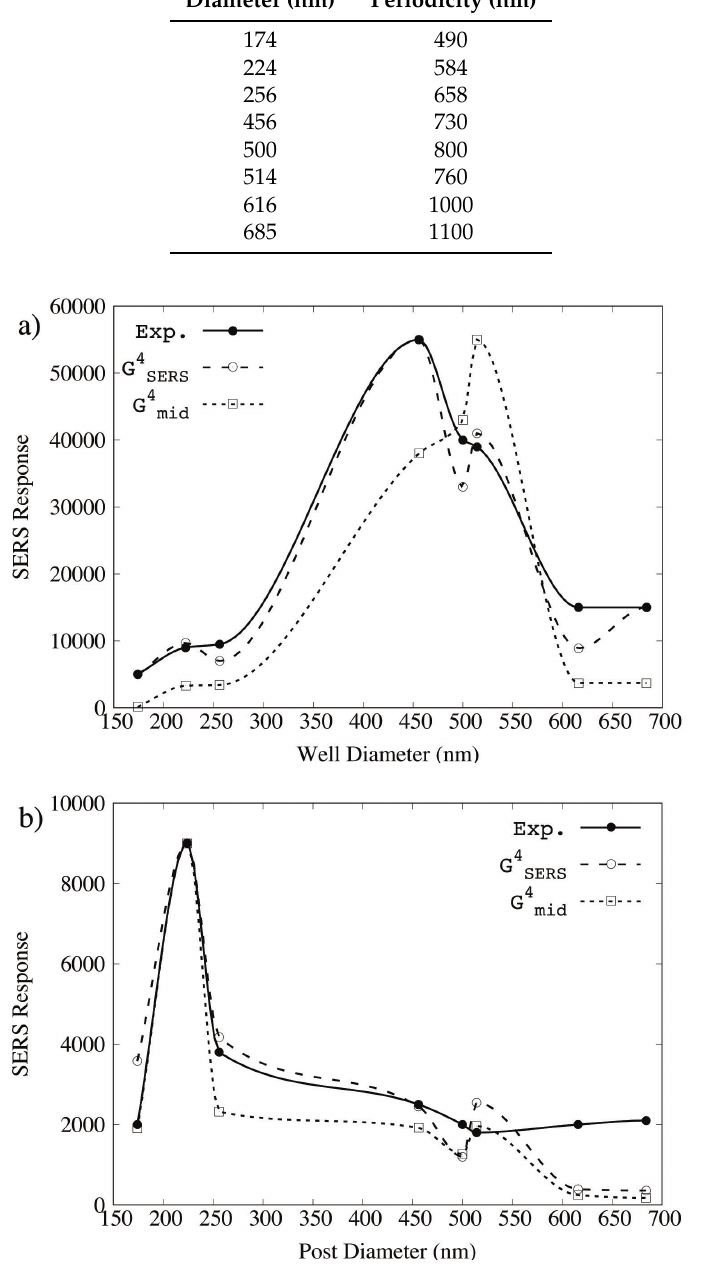
Figure 2. Comparison of experimental SERS response (exp) and calculated SERS responses ( G 4 and G 4 ) for the ( a ) NW and ( b ) NP geometries. Experimental SERS response for the NW and NP mid geometries are taken from Refs. [13,14], respectively. Experimental values are plotted with filled circles. SERS responses using Equation (1) are plotted with open circles. SERS responses calculated using Equation (2) are plotted with open squares. Solid and dashed/dotted lines correspond to spline interpolation between data points and are meant for ease of visualization only. Calculated SERS responses are scaled such that maximum values equal the experimental